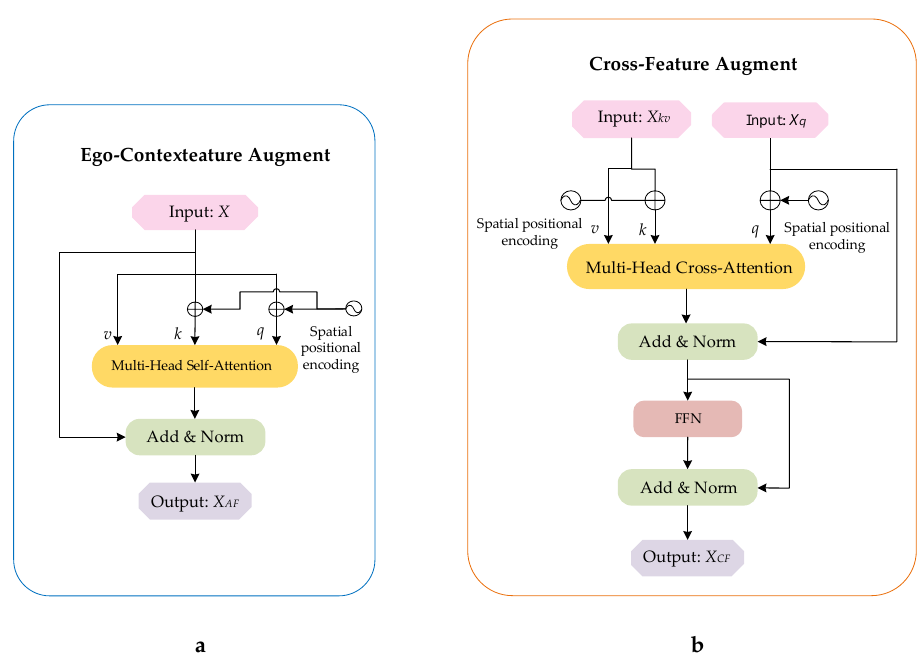
Figure 6. The structure of the Ego-Context Augment module (ECA) is on the left ( a ), and that of the Cross-Feature Augment module (CFA) is on the right ( b ). In particular, there is one input in the ECA and two inputs in the